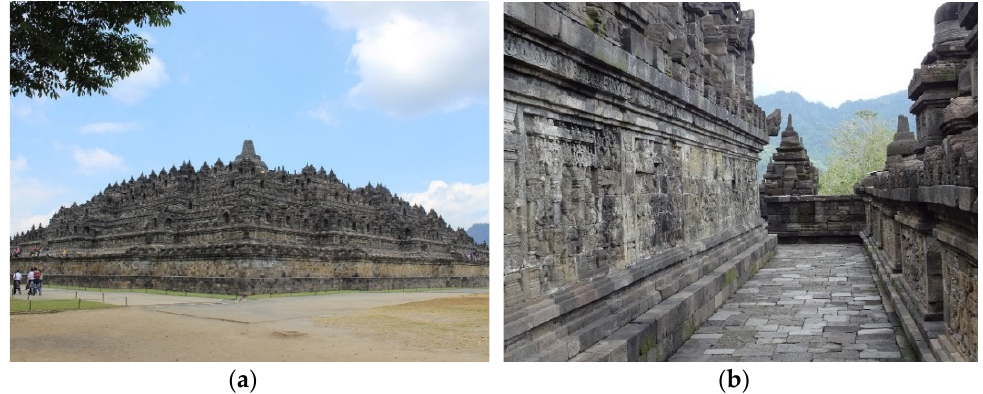
Figure 1. Borobudur Temple in Indonesia (photograph). ( a ) Borobudur temple; ( b ) corridors with 1460 narrative relief panels on walls. The total relief surface is 2500 square meters.